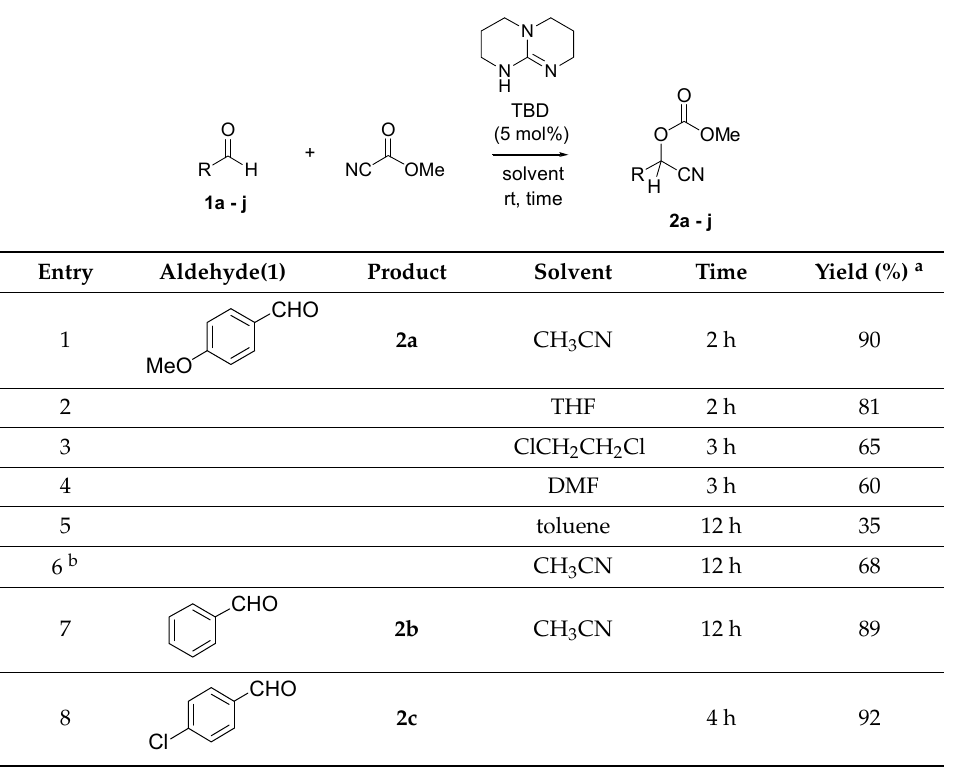
Table 1. TBD (1,5,7-triazabicyclo[4,4,0]dec-5-ene) catalyzed cyanation of aldehydes with methyl